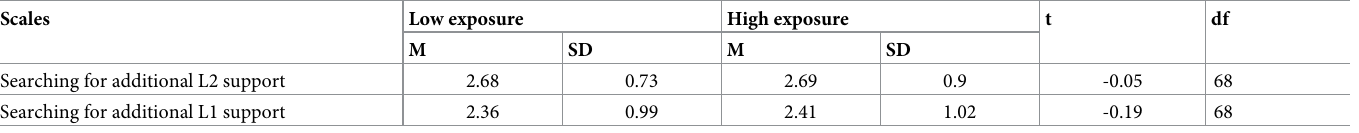
Table 10. Descriptive statistics and t -test results for science learning strategies (low exposure vs. high exposure).